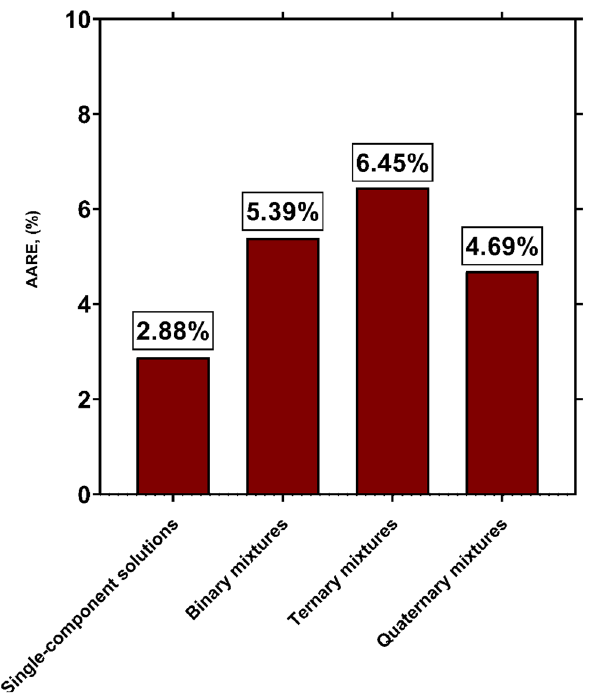
Figure 7. AARE values corresponding to GPR model for predicting H 2 S solubility in single and multicomponent solvents (created by GraphPad 8.4.3.686 145 ).